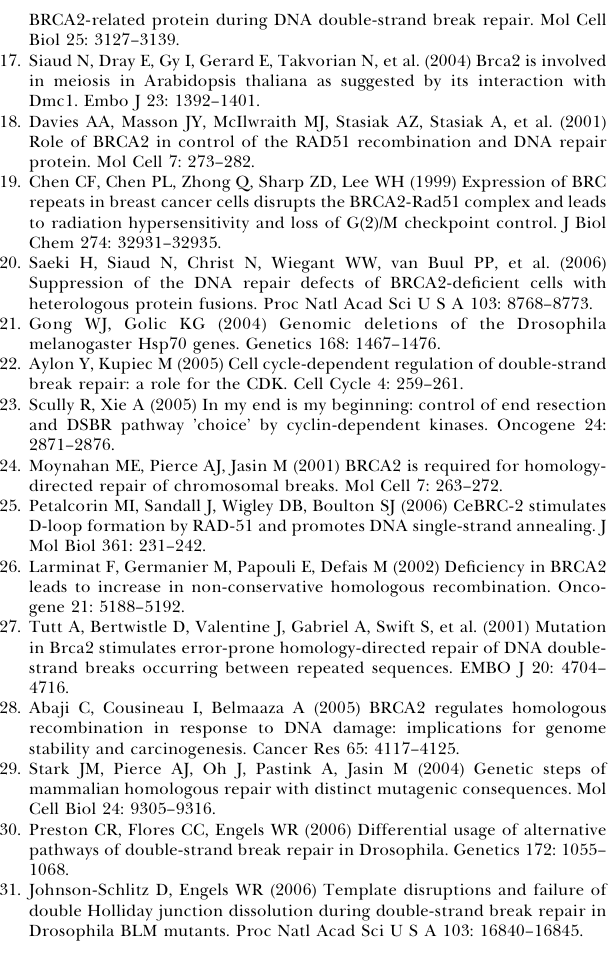
Figure S1. brca2 Is Not Required for the Checkpoints That Respond to Irradiation Damage in the Drosophila Larval Wing Discs and Brain